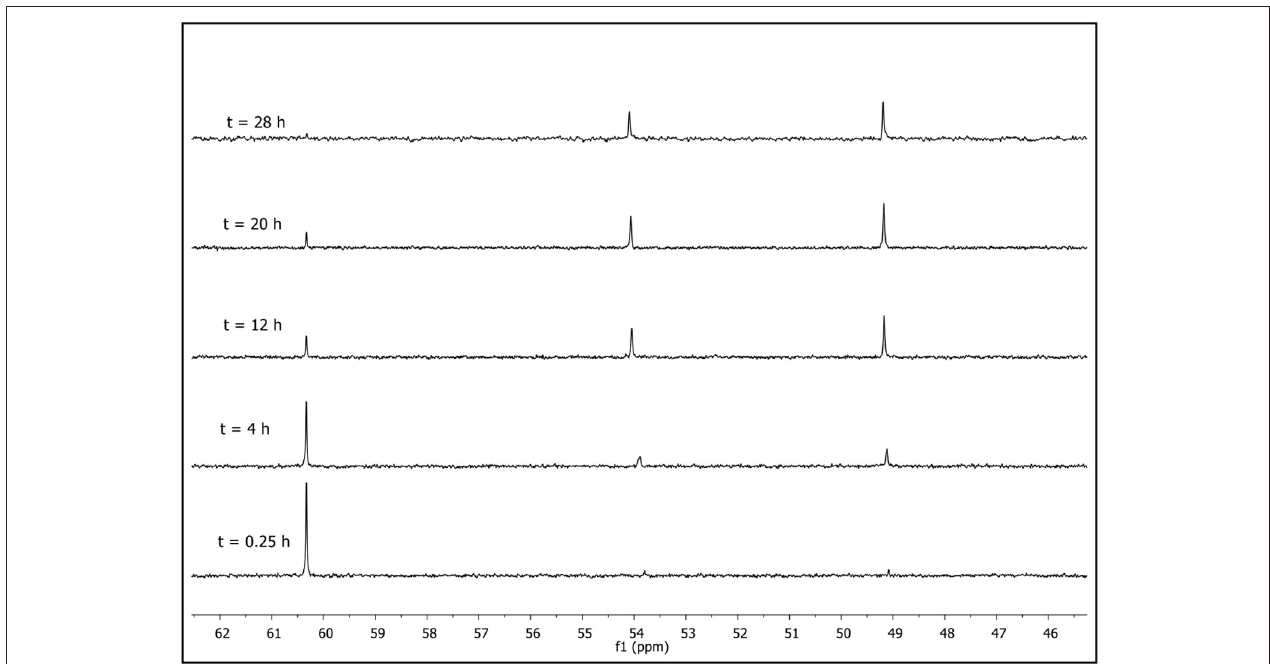
FIGURE 3 | Progressive 31 P NMR spectra obtained for degradation of 1 with piperidine (0.7M) at 25 ◦ C in BmpyrrNTF 2 .